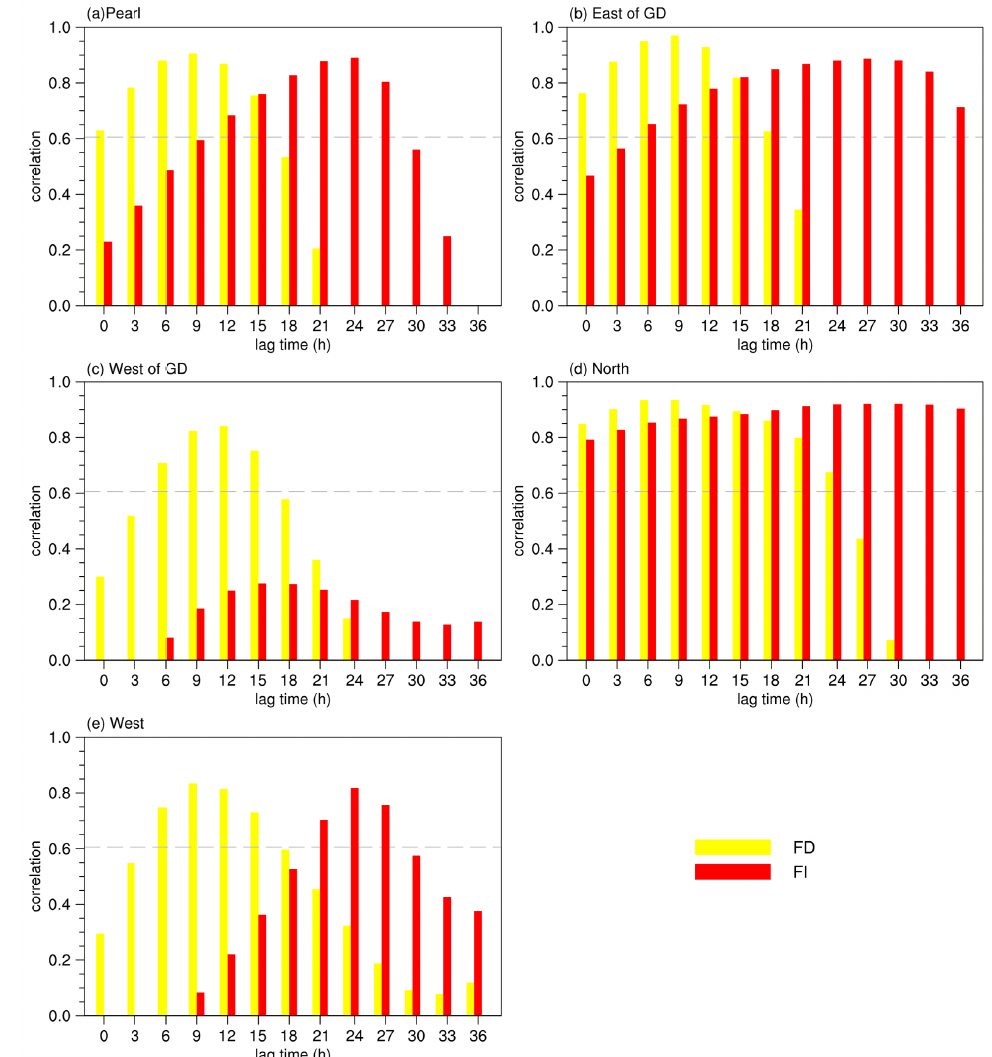
Figure 8. Simultaneous and lagged correlations between precipitation and flood duration/flood intensity in Guangdong province during typhoon